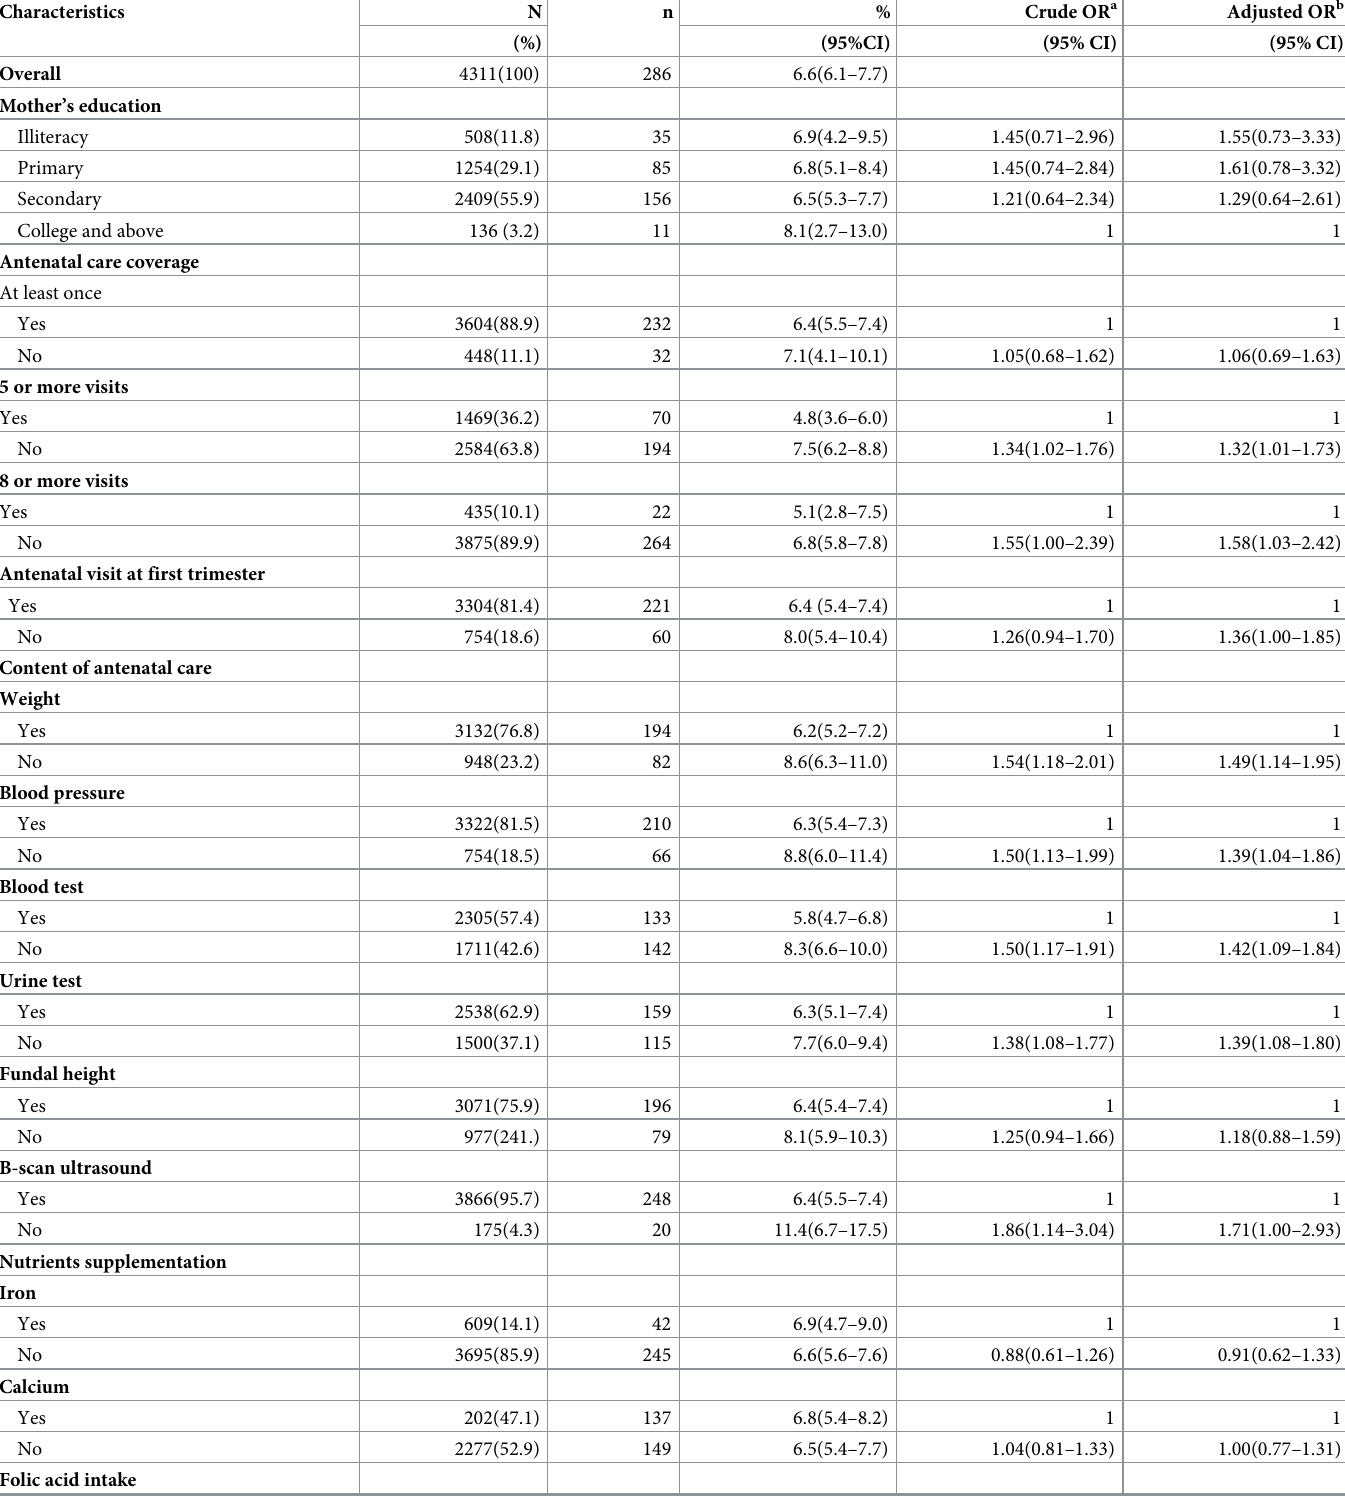
Table 3. Maternal factors for low birth weight among children in 42 counties of Western China (N = 4311, 2011).